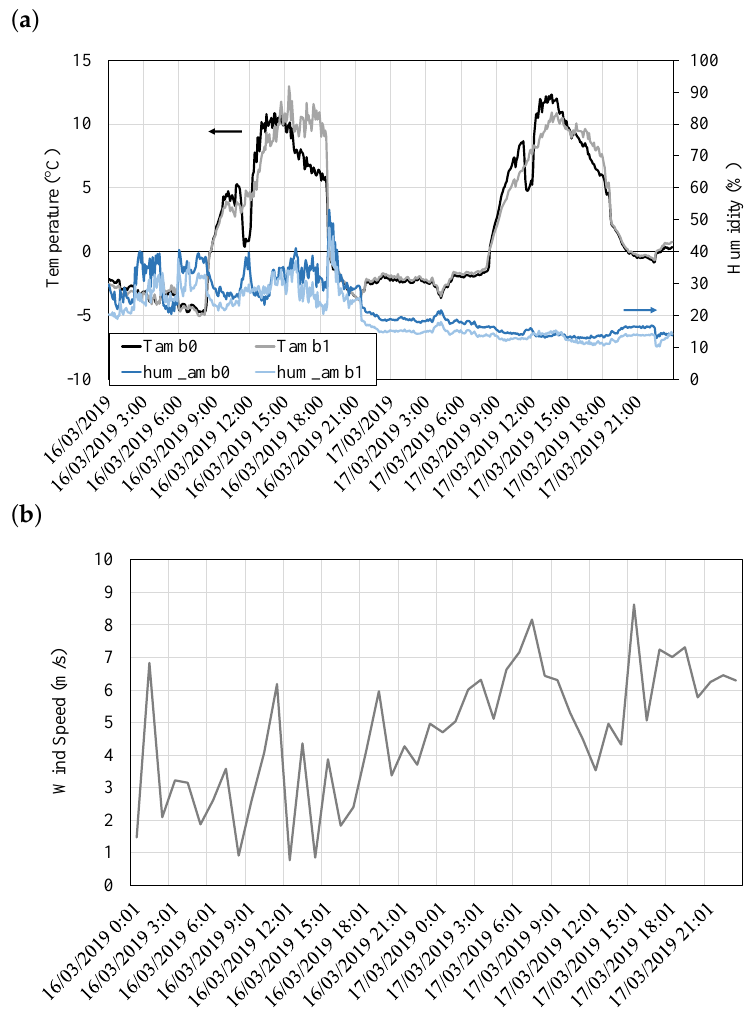
Figure 11. ( a ) Ambient temperature (left axis) and relative humidity (right axis) measured every 10 s. ( b ) Wind velocity measured every hour at a weather station